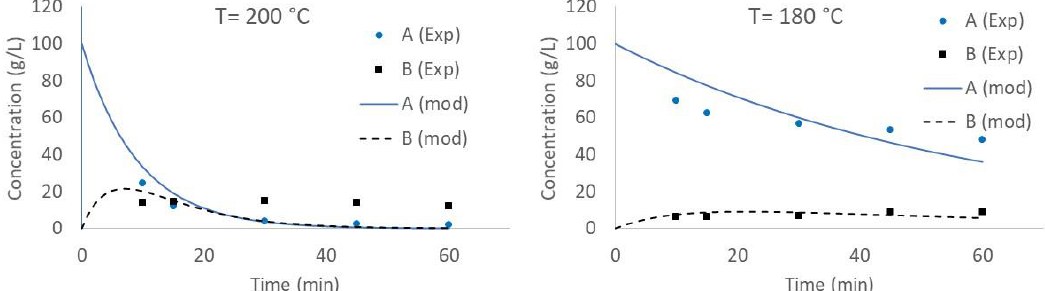
Figure 7. Fittings through power law modeling. ( A ) Cellulose concentration experimental and modeling (g/L); ( B ) HMF production experimental and modeling (g/L).